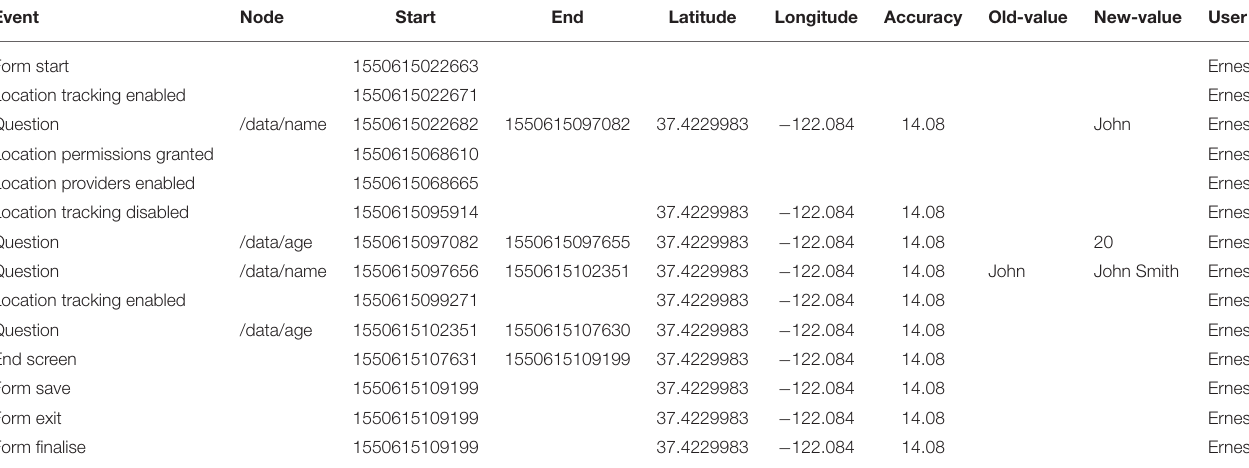
TABLE 1 | Exemplar ODK audit trail with coordinates, current user, timestamps, and form events logged.